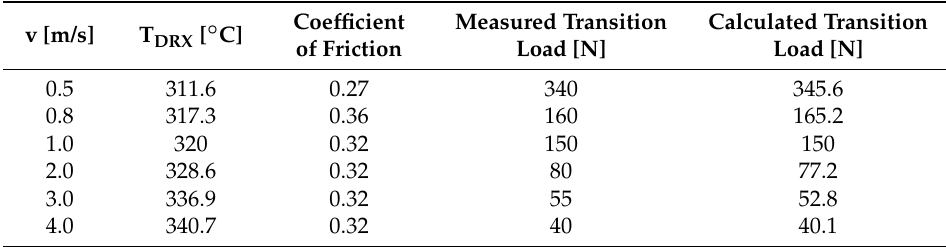
Figure 13. Optical microstructure of Mg97Zn1Y2 alloy hot-deformed at 320 ◦ C and at strain rate of 1 × 10 − 1 s − 1 . Table 4. Calculated DRX (dynamic crystallization) temperatures, transition load and coefficient of friction of Mg97Zn1Y2 alloy under different sliding